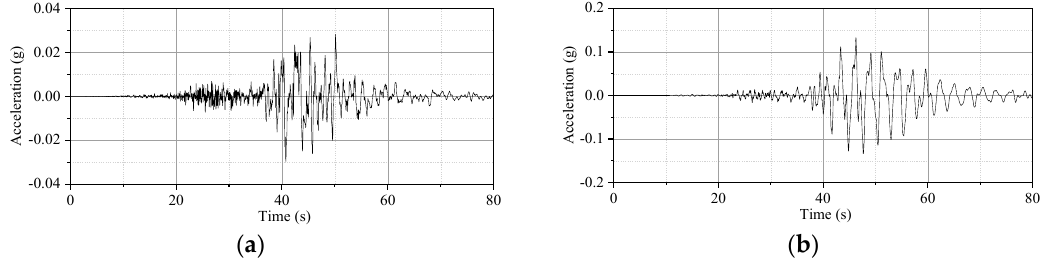
Figure 12. Comparison of ( a ) the bedrock ground motion record and ( b ) the computed ground surface acceleration time history.